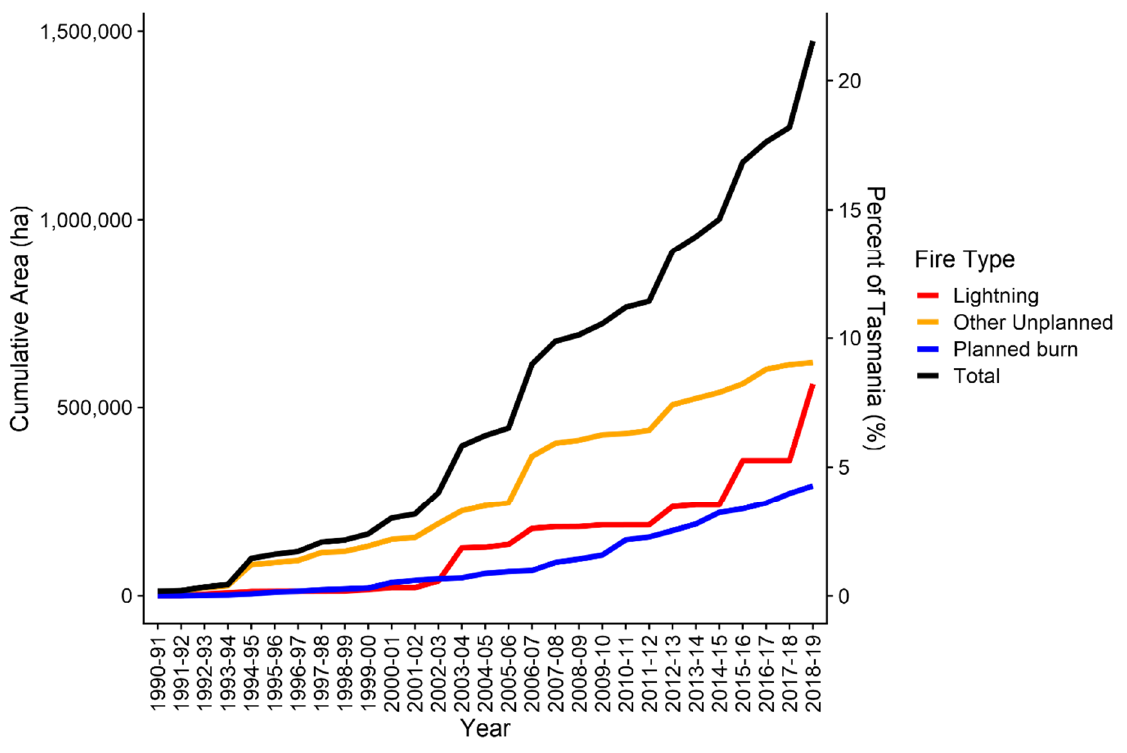
Figure 2. Cumulative area (in ha and % of the area of Tasmania) burned since 1990. The area burned is broken down by planned, lightning and other unplanned fires.